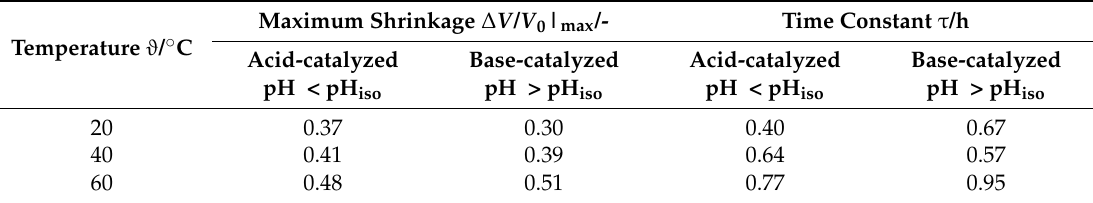
Figure 10. Relative shrinkage Δ V / V 0 of the gel droplets, natural syneresis for different temperatures ϑ , acid-catalyzed ( a ) and base-catalyzed ( b ). Table 2. Maximum shrinkage Δ V / V 0 | max and characteristic time constant τ for the gel droplets ( d Drop ≈ 3 mm), natural syneresis, model parameters.